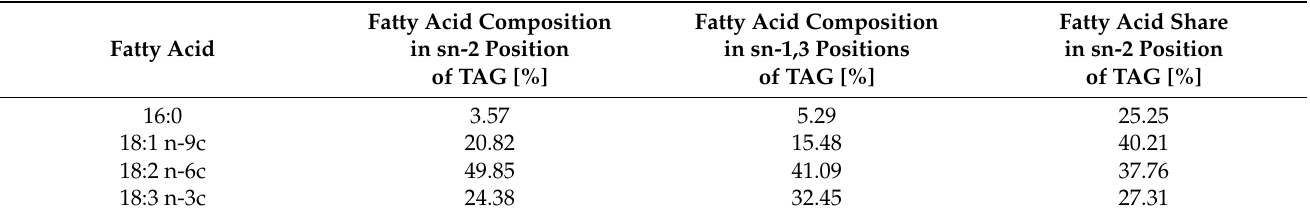
Table 4. Fatty acids composition in sn-2 and sn-1,3 positions of TAG and the share of fatty acids in internal position (sn-2) of TAG in strawberry seed